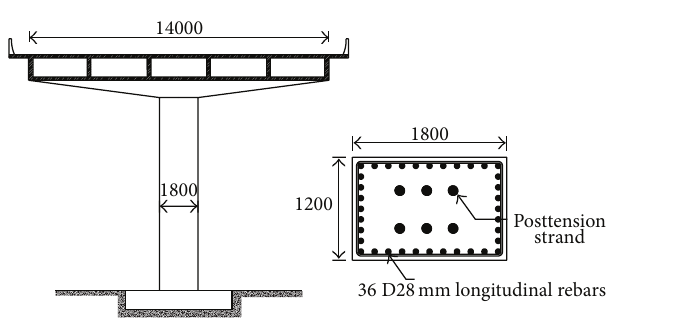
Figure 4: Bridge configuration and